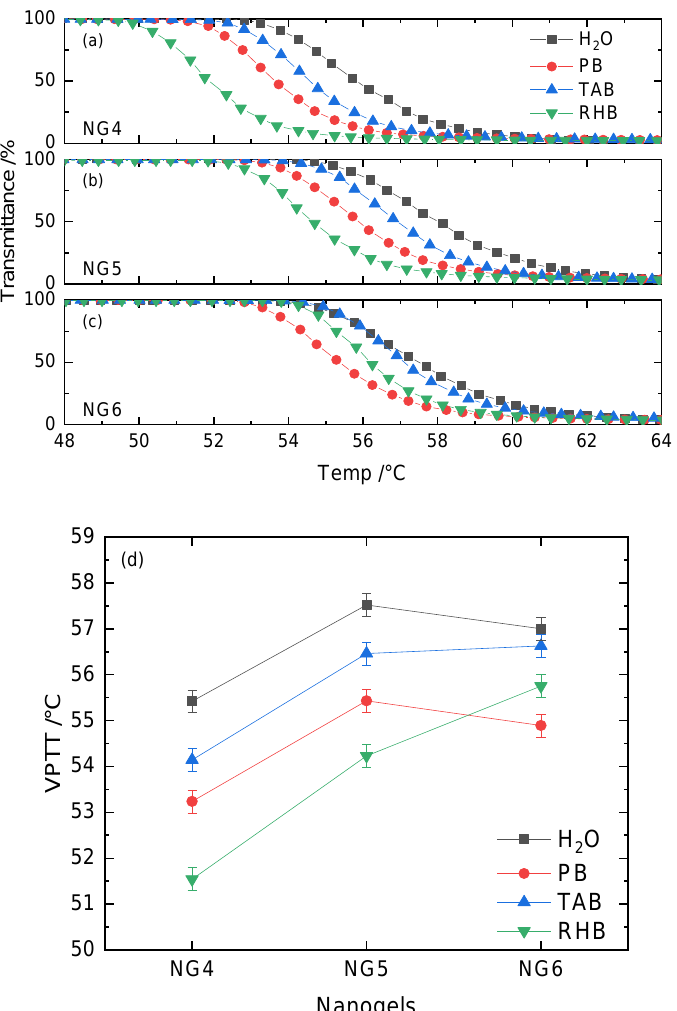
Figure 3. VPTT profiles of ( a ) NG4, ( b ) NG5 and ( c ) NG6 in H 2 O, PB, TAB and RHB. Their corresponding VPTT values are summarized in ( d ).